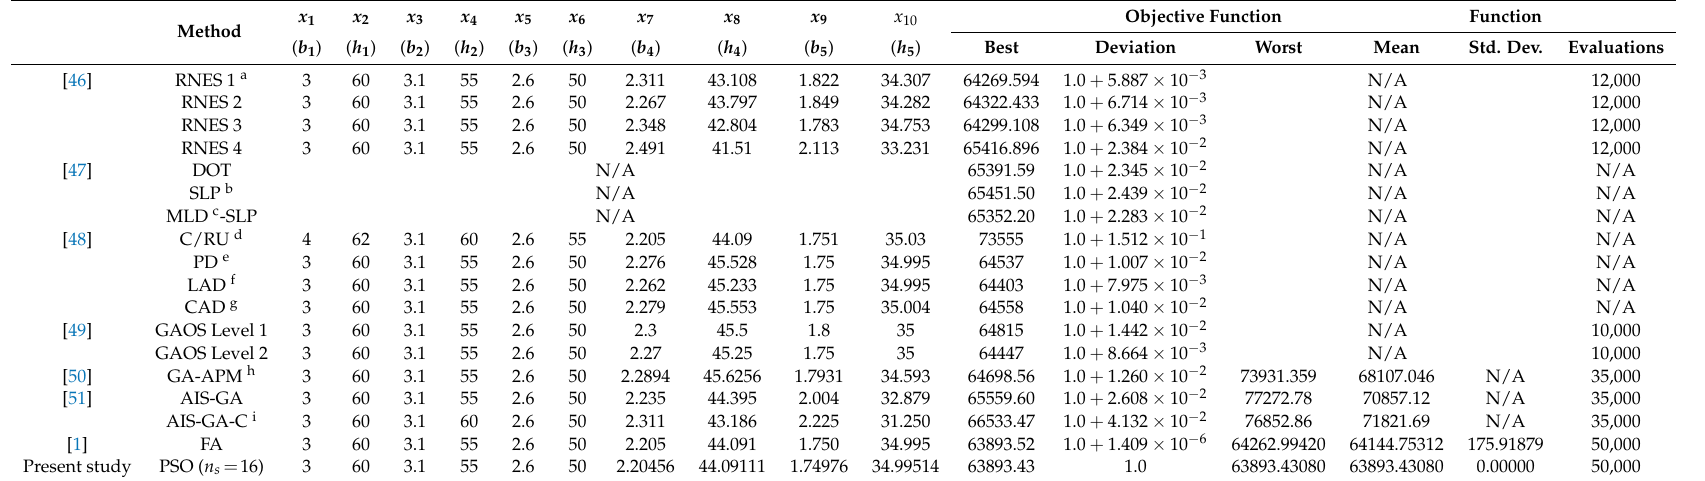
Table 10. Optimization results of the stepped cantilever beam design